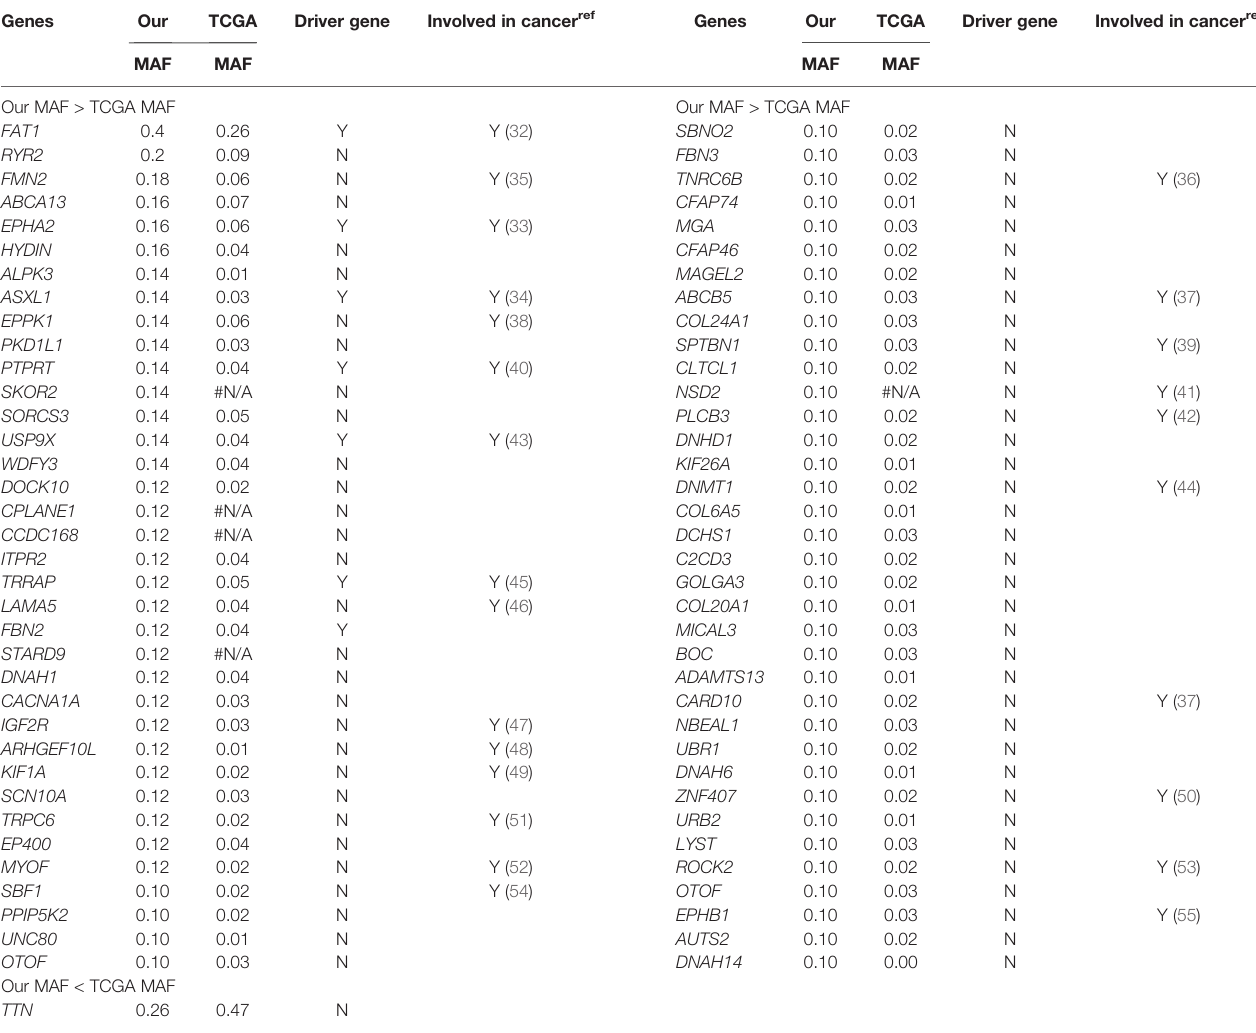
TABLE 2 | List of most frequently mutated genes in our study showed a statistically signi fi cant difference in mutation rates compared to TCGA-OSCC dataset. Genes